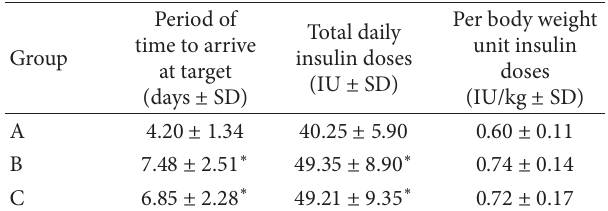
Table 2: Comparison of periods of time to arrival at target and daily insulin doses.